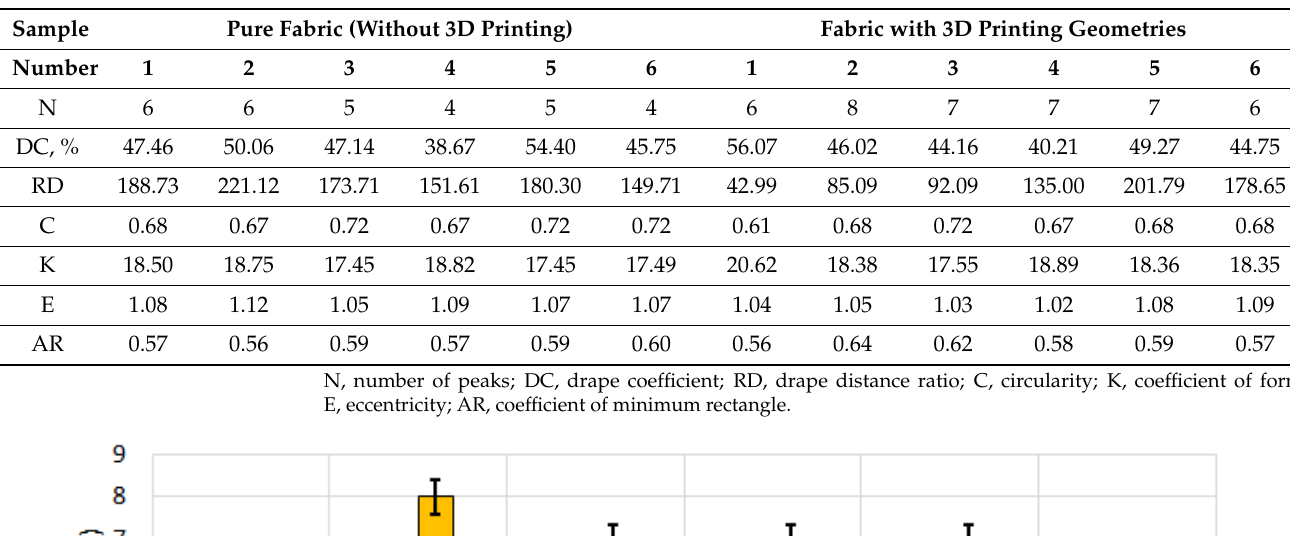
Table 4. Characteristics of draperies determined by the proposed algorithm.